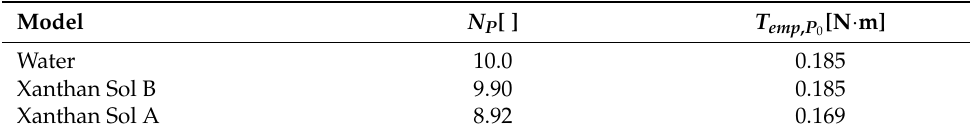
Table A1. Empirical characterization of the abiotic systems.